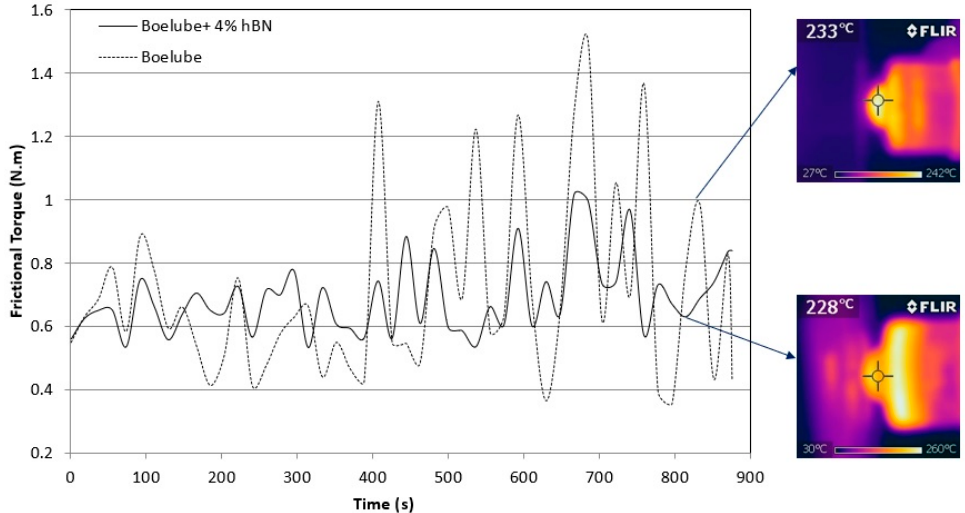
Figure 9. Frictional torque and surface temperature of the top WC ball against Ti lower balls at 3.5 GPa contact stress for Boelube and Boelube with hBN nanoparticles. With respect to wear, the tungsten carbide upper balls did not experience a measurable wear during the 15 ‐ min four ‐ ball tests for both Boelube and nanofluids. The average of wear mass of titanium lower balls in three tests with each of the nanofluids and in five tests with Boelube and the corresponding standard deviation of the wear mass data as the error bar are shown in Figure 10. The existence of MoS 2 and hBN nanoparticles in the MQL mist has reduced the sliding wear in the softer material, i.e., titanium. Several mechanisms through which dispersed nanoparticles with a lamellar structure, such as MoS 2 and hBN in nanolubricants and nanofluids, result in lower friction and wear are contemplated in the literature. These mechanisms include the formation of a transferred solid lubricant film [33], easy shearing of trapped nanoparticles at the interface [34], rolling of spherical nanoparticles in the contact zone and reducing asperity contact by filling the valleys of contacting